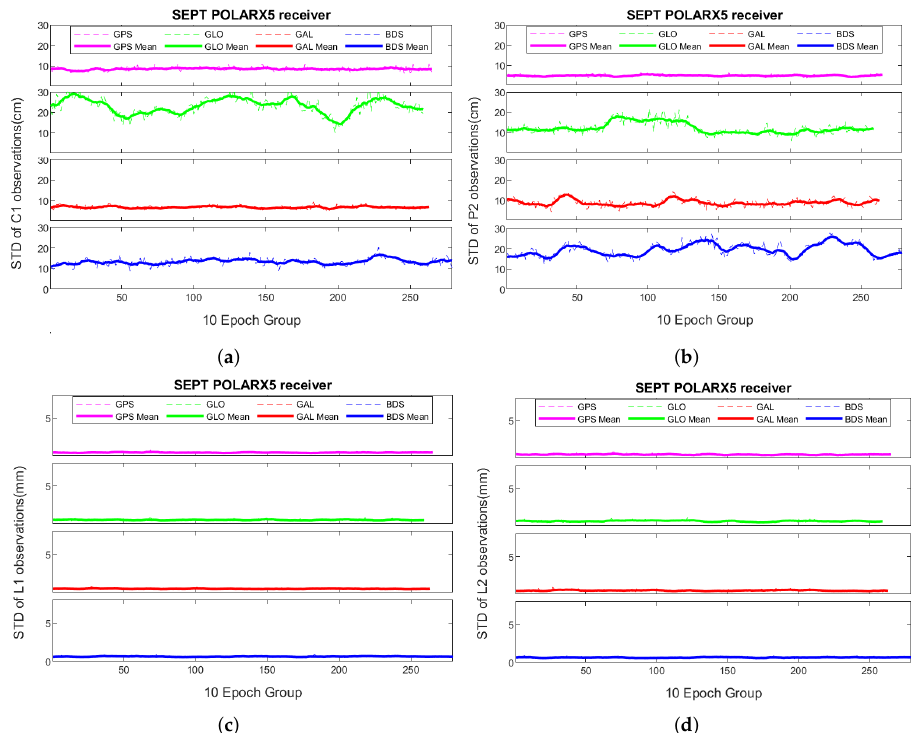
Figure 3. Groupwise estimated standard deviations for each system (dashed line) with their average values in 10 epoch group windows (bold line) over a very short baseline with SEPT POLARX5 receiver: ( a , b ) for the C1 and P2 in cm; ( c , d ) for the L1 and L2 in mm.